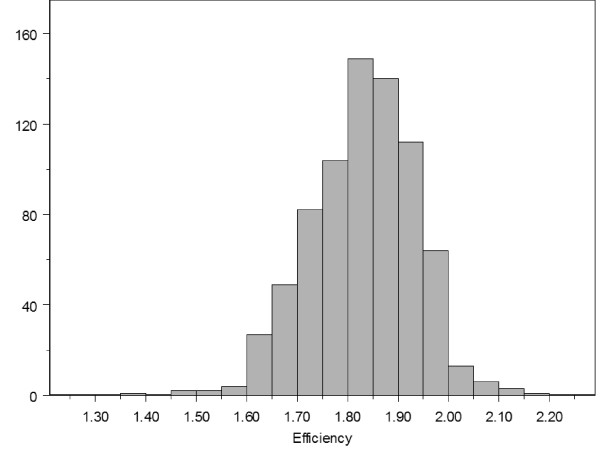
Distribution of efficiency values in the complete data set. Efficiency of 704 PCR reactions encompassing different cDNA samples, primers and dilutions are shown as determined using the LinReg method, as done in Figure 2B.